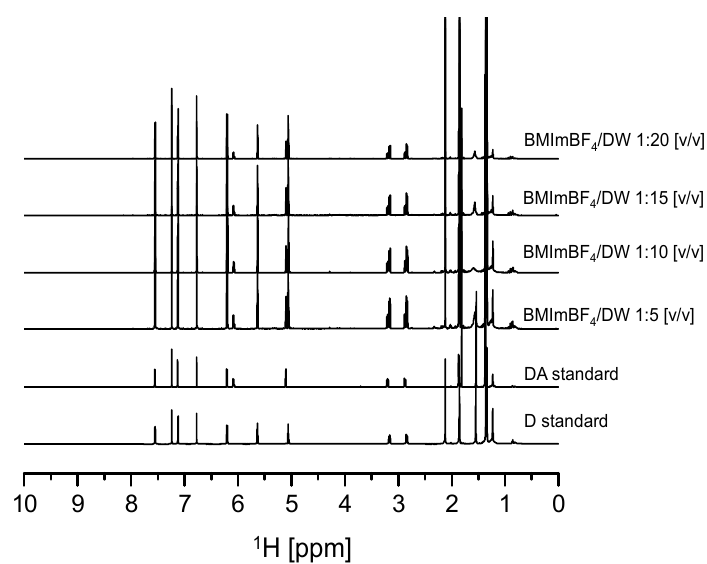
Figure 8. Solution-state 1 H-NMR spectra for D and DA precipitated from A. gigas –(BMIm) BF 4 extraction solution at di ff erent DW ratios ( v / v ) (CDCl3).